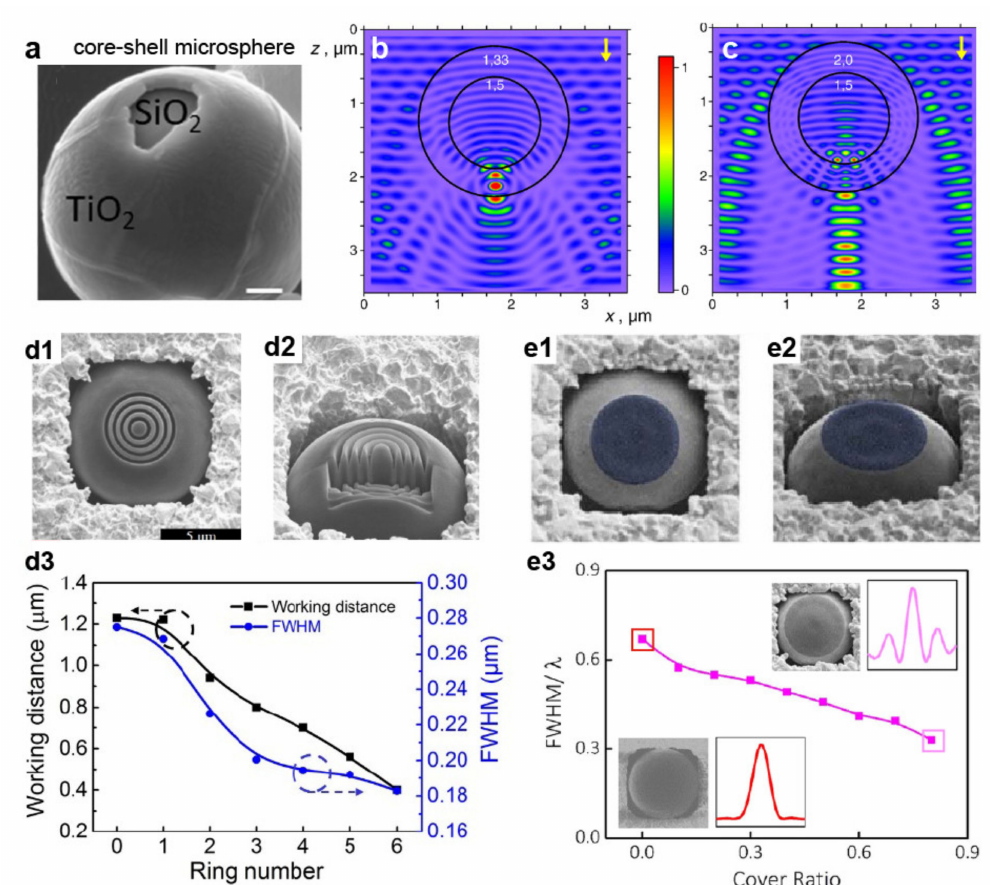
Figure 2. ( a ) Scanning electron micrograph (SEM) of a core-shell microsphere. Scale bar 100 nm. Reprinted with permission from [43] Copyright 2018 John Wiley & Sons, Inc. ( b , c ) Optical field distribution of core-shell microspheres with refractive index of the core 1.5 and that of the shell 1.33 ( b ) and 2.0 ( c ) under plane wave illumination. The field amplitudes are normalized to their maxima. Reprinted with permission from [21] Copyright 2010 Elsevier. ( d , e ) Surface-decorated microspheres. Top ( d1 ) and side ( d2 ) views of a microsphere decorated with four rings. ( d3 ) Width and working distance versus ring number. Reprinted with permission from [47] Copyright 2015 Optical Society of America. Top ( e1 ) and side ( e2 ) views of a center-covered microsphere. In blue the cover. ( e3 ) Nanojet width for various cover ratios. The insets show scanning micrographs and lateral intensity profile at the focal spot for cover-ratio of 0.0 and 0.777, respectively. Adapted with permission from [48] Copyright 2016 Springer